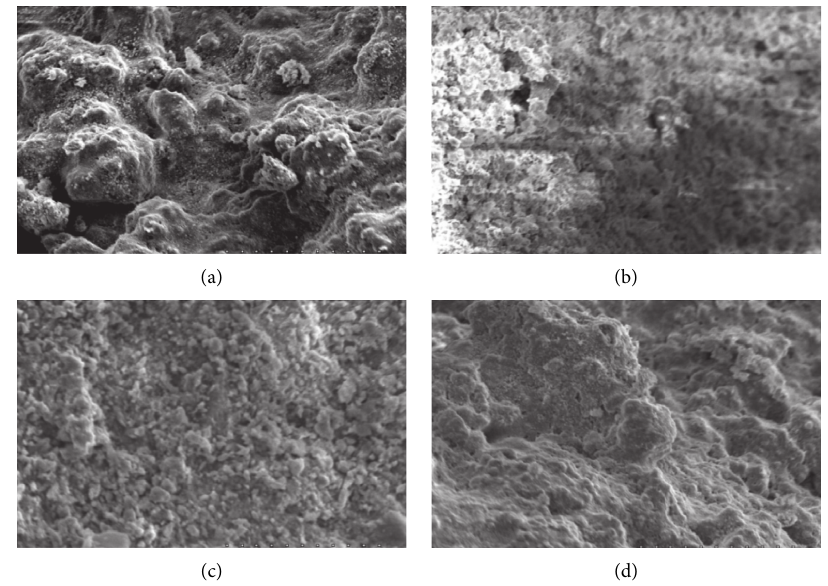
Figure 11: SEM pictures of RA (500x). (a) C-3 method. (b) C-7 method. (c) N-P method. (d) H